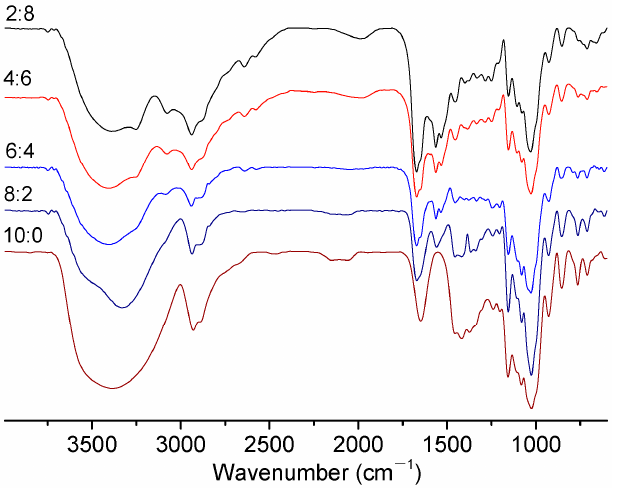
Figure 3. FTIR spectra of the composite films with different St/PL mass